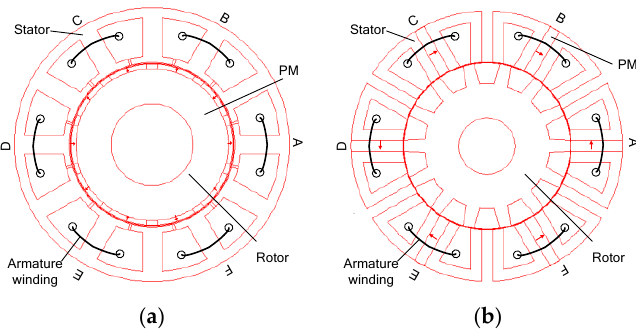
Figure 1. Fault tolerant PM machines. ( a ) Fault tolerant rotor-PM(FTRPM) machine; ( b ) Fault-tolerant FSPM (FTFSPM) machine.